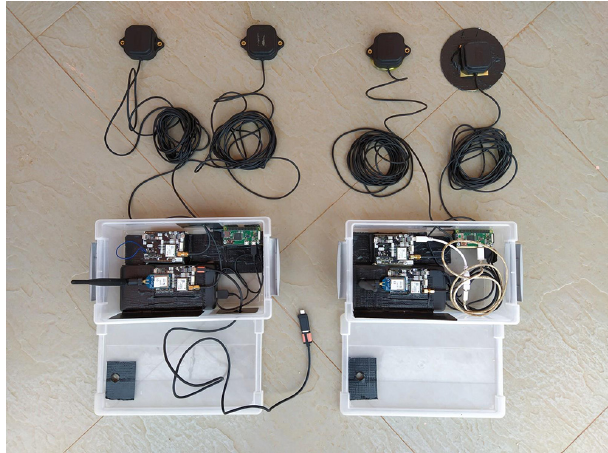
Figure A1. Two sets of RTK GNSS equipment: one based on a long-range radio connection and one based on a 4G connection.